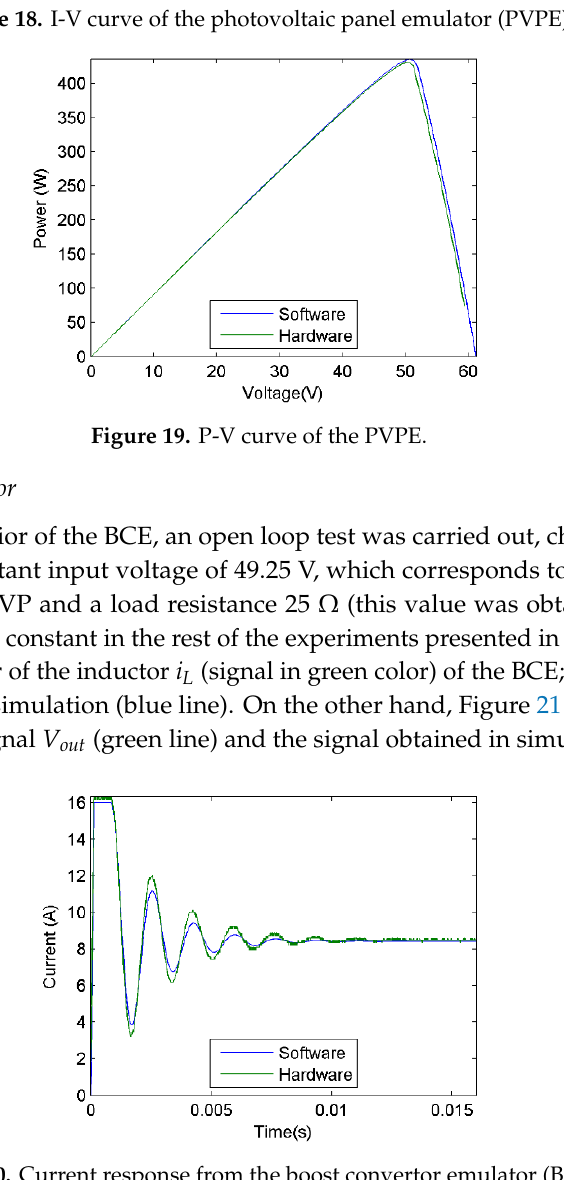
Figure 21. BCE voltage response. 4.3. Open Loop Photovoltaic System Emulator Once the PVSE shown in the Figure was integrated, its behavior in open loop was tested with a step input of 50% in the duty cycle. Figure 22 shows the behavior of the voltage supplied to the load connected to the BCE output. Figure 22. Voltage at the BCE output in open loop in the PVSE. This response is essentially the response of the PVSE, so at this point the error obtained was calculated when comparing the results of the software simulation with the hardware simulation. Figure 23 shows the results obtained for the PVSE output absolute error.